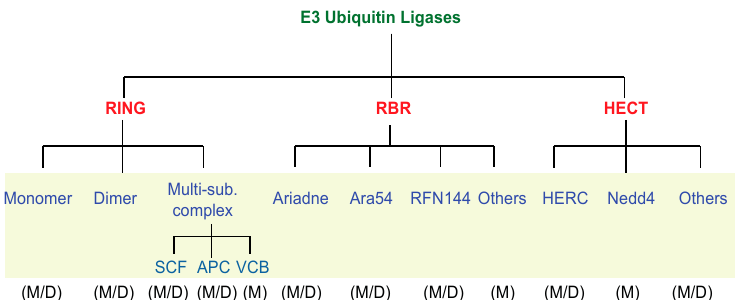
Figure 3. Summary of the E3 ubiquitin ligases family members. Mammals (M) and Dictyostelium (D) E3 ubiquitin ligases members have been classified and compared according to their structural features.